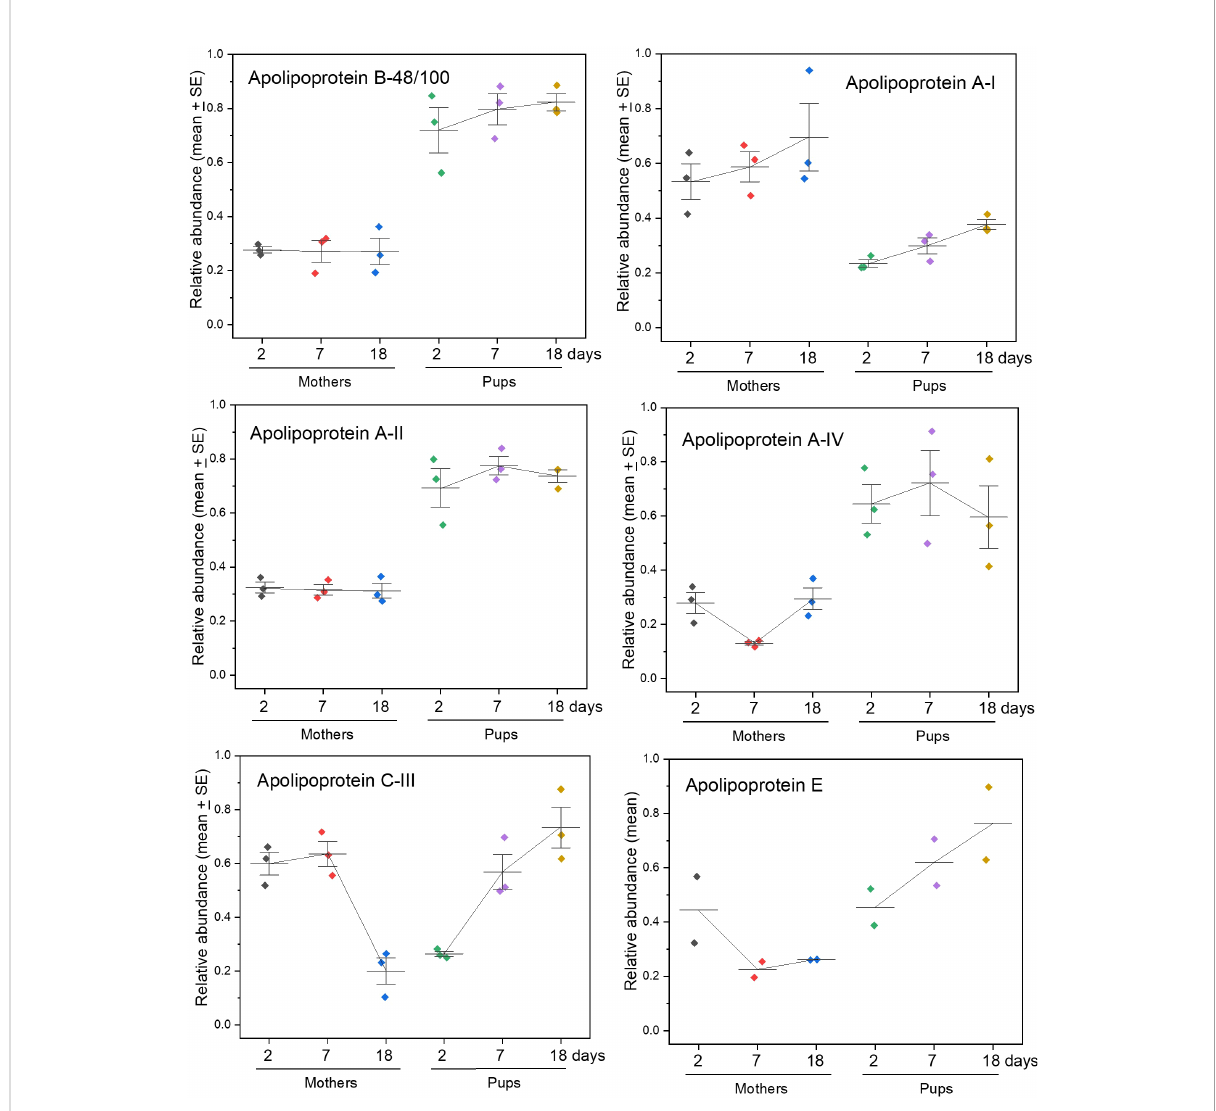
FIGURE 3 Changes in apolipoproteins that contribute to lipoprotein particles - chylomicrons (the largest lipoprotein particles), LDL, HDL, etc. ApoB-48 is the main component of chylomicrons synthesised in the intestine as an abbreviated form of ApoB-100 which is instead mainly produced in the liver - interrogation of genome databases with the TMT proteomics data amalgamates the two proteins. The data for ApoA-1 shown here were obtained using TMT proteomic searches that identi fi ed this protein from the Weddell seal genome, and data indicating a less distinct trend as derived from the harbour seal genome are given in Figure S2; the amino acid sequences of ApoA-1 are at least 97% identical or identical between these and grey seals. See Supplementary Files A, B for for the statistical analysis of differences between mothers and pups for each protein for each sampling